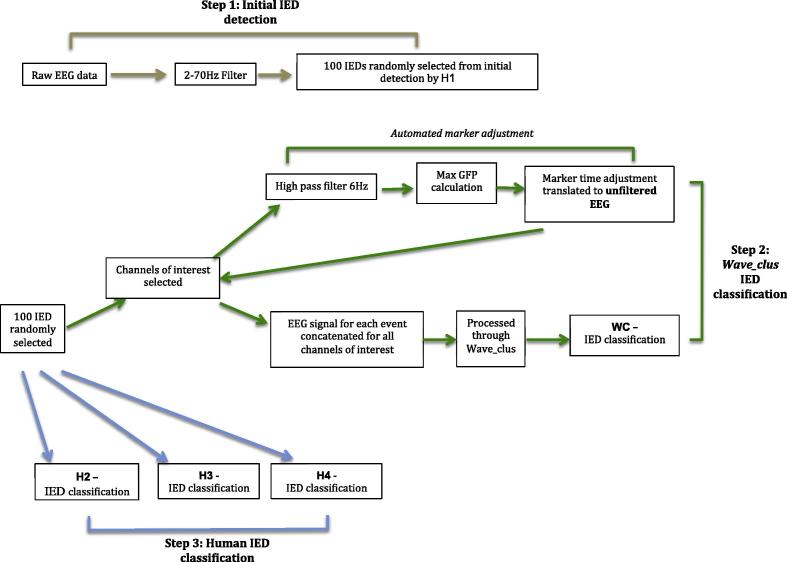
EEG reviewer and WC classification: Step 1: Initial IED detection of 100 lEDs carried out by HI. Step 2: The 100 lEDs detected by HI are classified by Wave_clus. This involves selecting channels of interest and adjusting the marker of the sharp wave according to GFP. Step 3: The same set of 100 lEDs detected by HI are independently classified by 3 EEG reviewers H2, H3 and H4. These three steps are carried out for all patients.